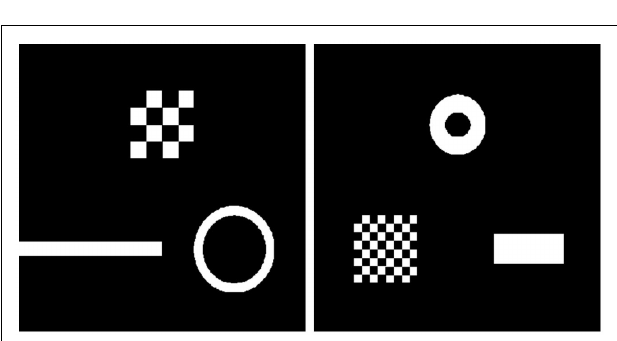
FIGURE 2 | Example stimuli for Phase II of the experiment, the learning